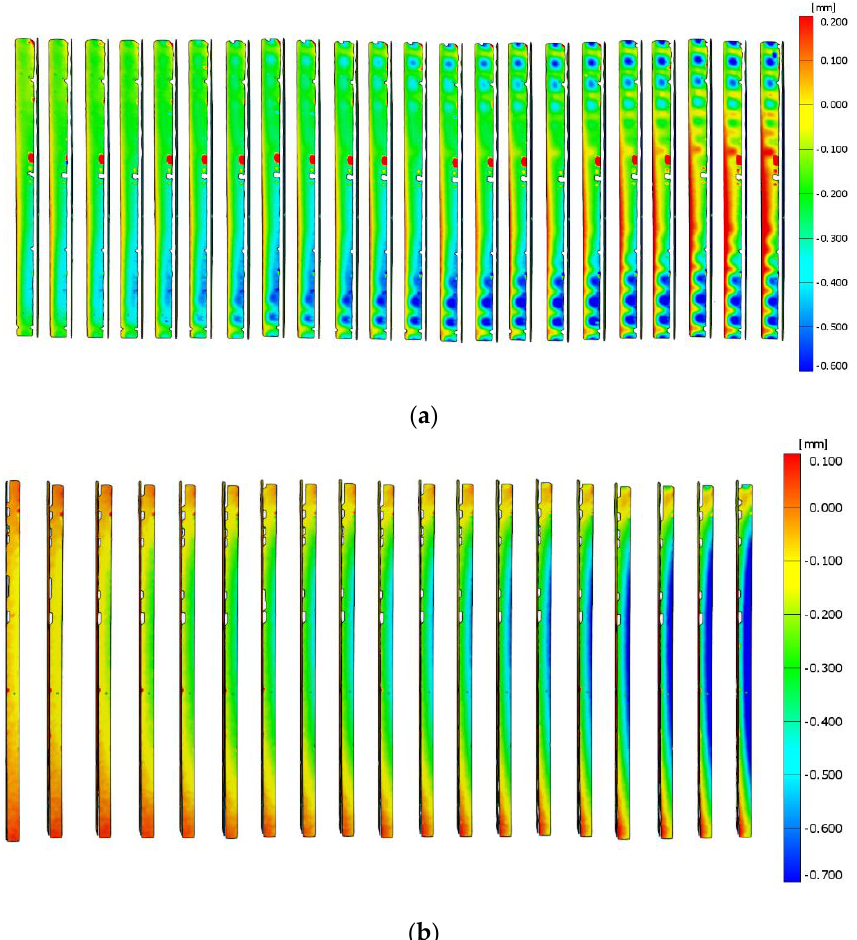
Figure 17. ( a ) . Results of tests carried out with ARAMIS for column B3—displacements on web. ( b ) Results of tests carried out with ARAMIS for column B3—displacements on flange. ( b ) Results of tests carried out with ARAMIS for column B3—displacements on